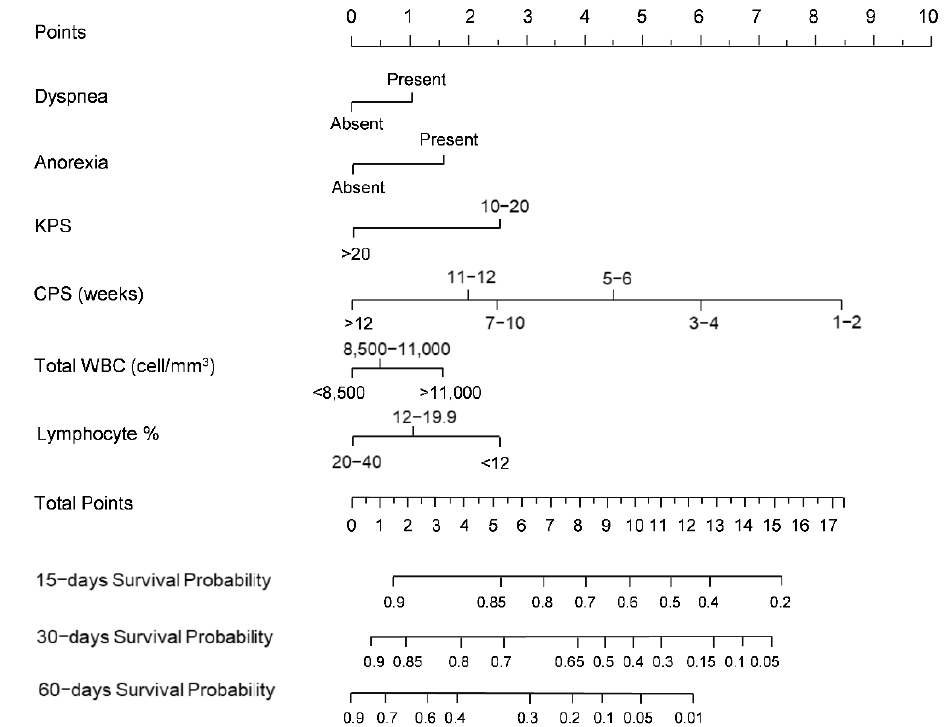
Figure 1. PaP score nomogram (development cohort) predicting 15-, 30-, and 60-day survival. To estimate risk, points were assigned for each independent variable by drawing a line upward form the variable value to the axis labeled “Points”. All points were then summed and plotted on the “Total points” axis; then, a straight line was drawn from the total points axis to the 15-, 30- and 60- days survival axis. KPS: Karnofsky Performance Status; CPS: Clinical Prediction of Survival; Total WBC: Total White Blood Count.